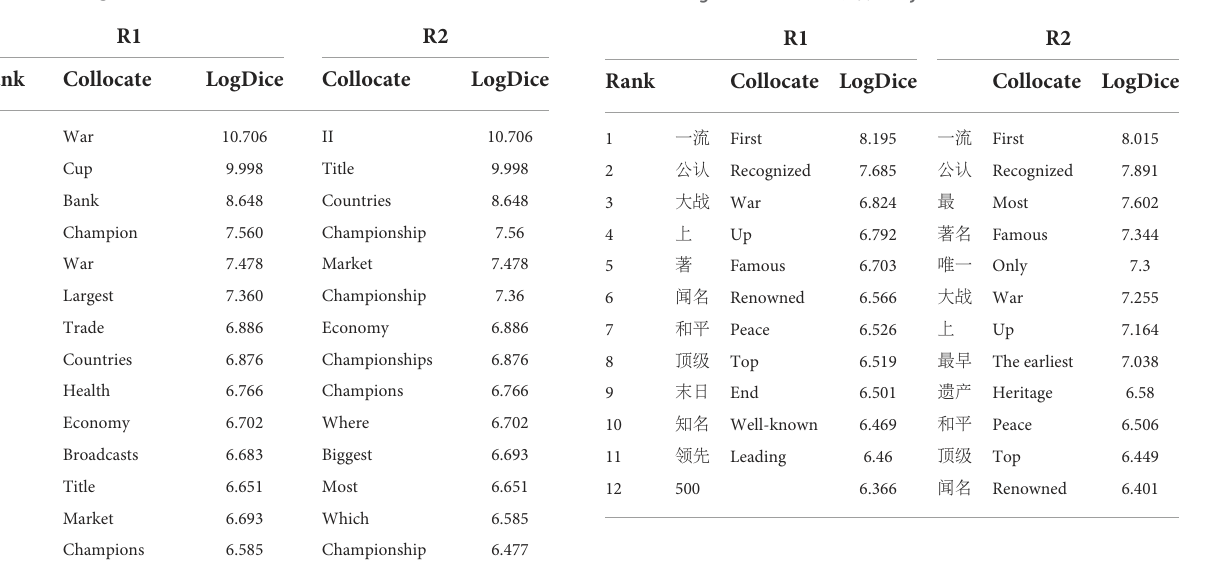
TABLE 4 Right collocates of 世 界 shi4jie4